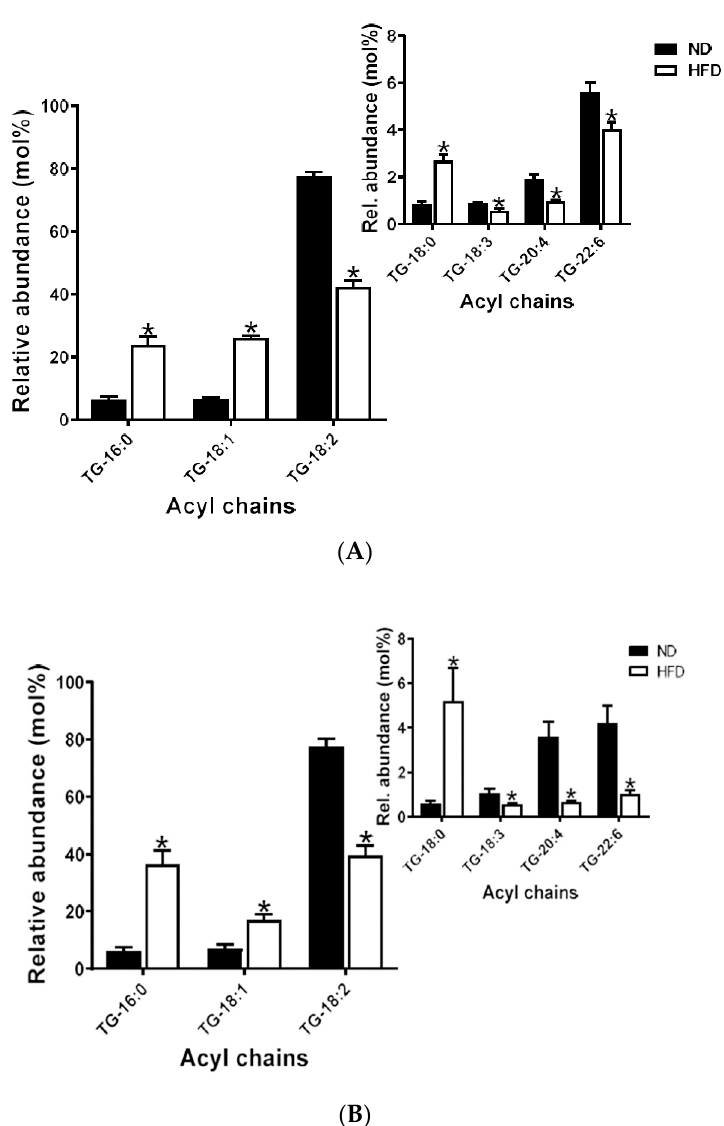
Figure 5. ( A ) Plasma triglyceride species detected; inset shows species with low relative abundance. Data are expressed as means ± SEM, * p < 0.05. Asterisks indicate a significant difference compared to the matched ND value. ( B ) Meibum triglyceride species detected; inset shows species with low relative abundance. Data are expressed as means ± SEM, * p < 0.05. Asterisks indicate a significant difference compared to the matched ND value.